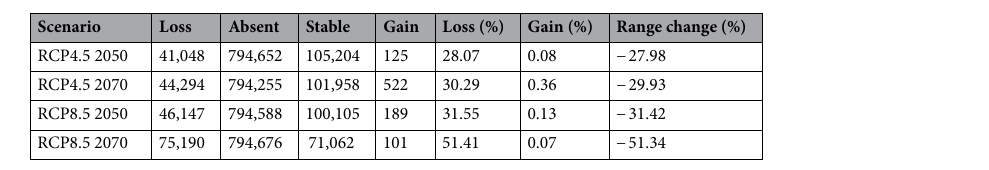
Table 5. Summary of the range change statistics for Dactylorhiza hatagirea under climate change scenarios compared to current climatic conditions.